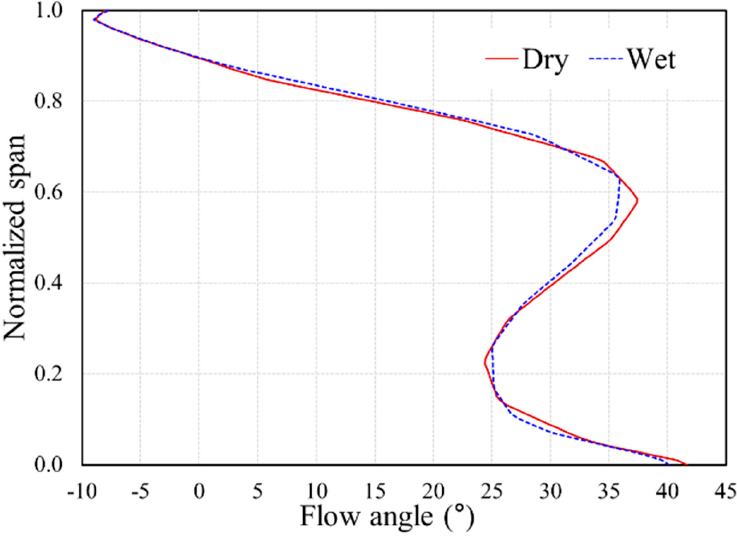
Figure 8. Impeller outlet flow angle distribution of dry and wet compression.